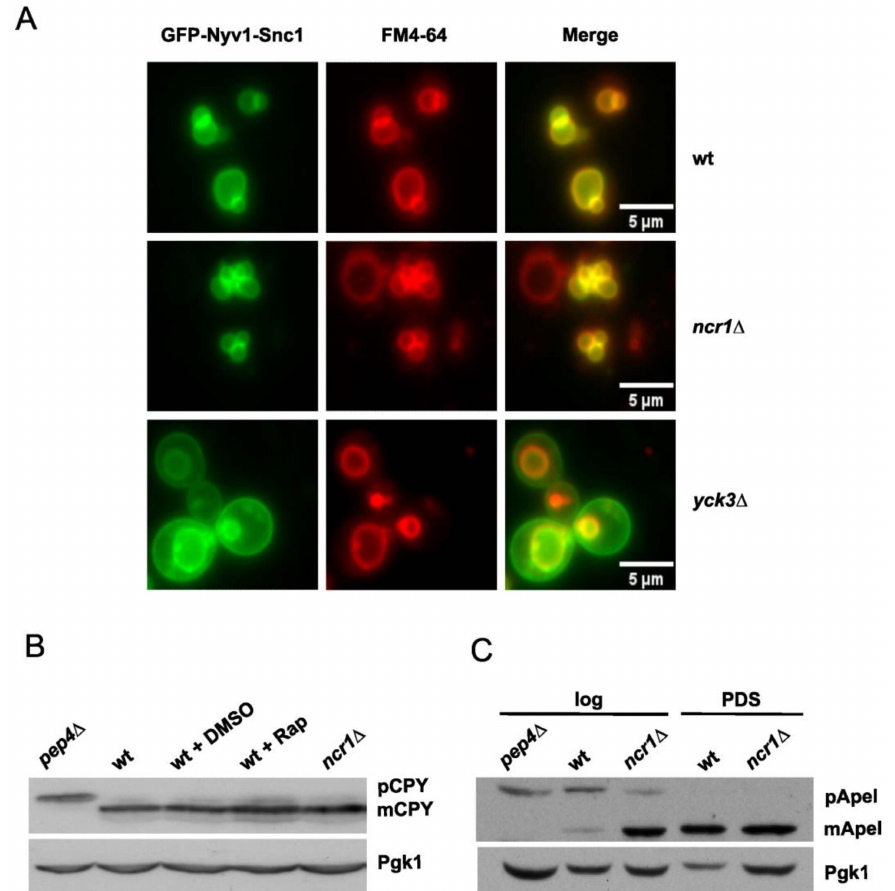
Figure 3. Loss of Ncr1 does not impair protein trafficking to the yeast vacuole. ( A ) ALP-AP-3 pathway: wild-type (wt), ncr1 ∆ , and yck3 ∆ cells carrying a plasmid expressing a GFP-tagged Nyv1-Snc1 fusion protein grown to exponential phase were incubated with 0.024 mM FM4-64 (vacuolar membrane probe) for 1 h and observed by fluorescence microscopy. ( B ) CPY pathway: cells were grown to exponential phase and proteins were analyzed by immunoblotting, using anti-CPY antibody. Bands corresponding to the proenzyme (pCPY) or the mature enzyme (mCPY) are indicated. Pgk1 was used as loading control. Cells lacking Pep4, which is involved in the proteolytic activation of pCPY to mCPY, were used as a negative control. As a positive control, wild-type cells were treated with rapamycin (200 ng mL − 1 ) for 4 h (wt + Rap). The original figure is shown in Supplementary Figure S4. ( C ) Cvt pathway: cells were grown to exponential (log) and post-diauxic shift [(PDS), 48 h after log] phases, and the processing of pApeI to mApeI was analyzed by immunoblotting, using anti-ApeI antibody. Pgk1 was used as loading control. Cells lacking Pep4, which is involved in the proteolytic activation of pApeI to mApeI, were used as control. The original figure is shown in Supplementary Figure S5. Representative images of at least three independent experiments are